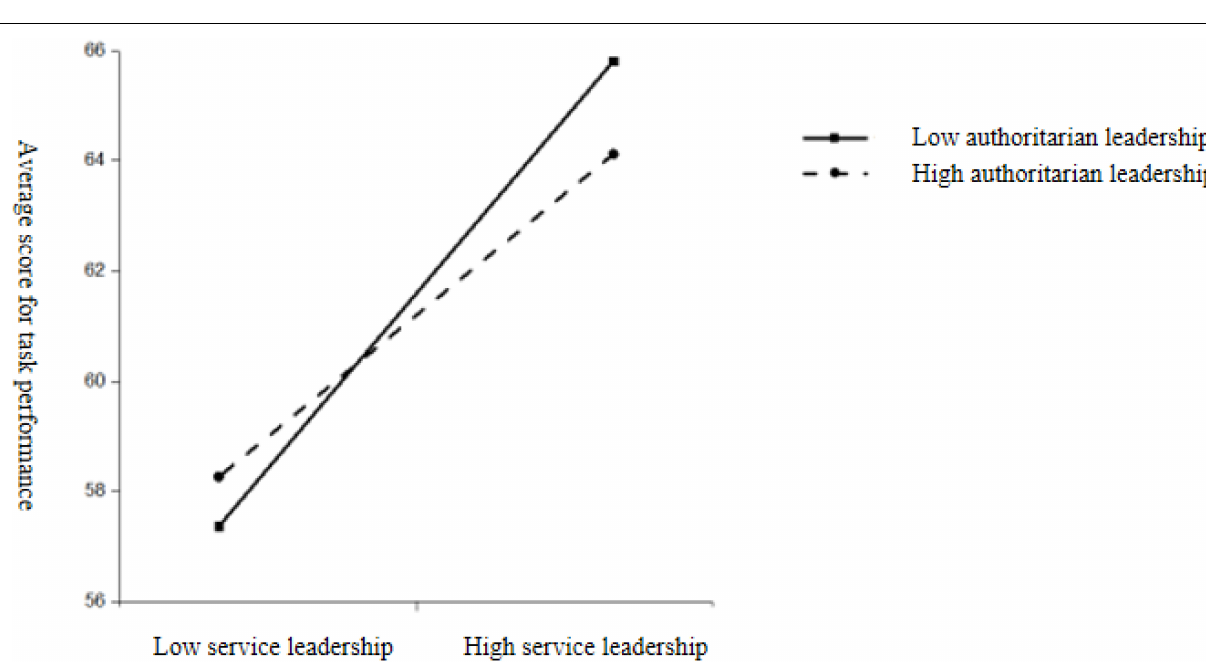
FIGURE 5 | The interaction between authoritarian leadership and servant leadership on task